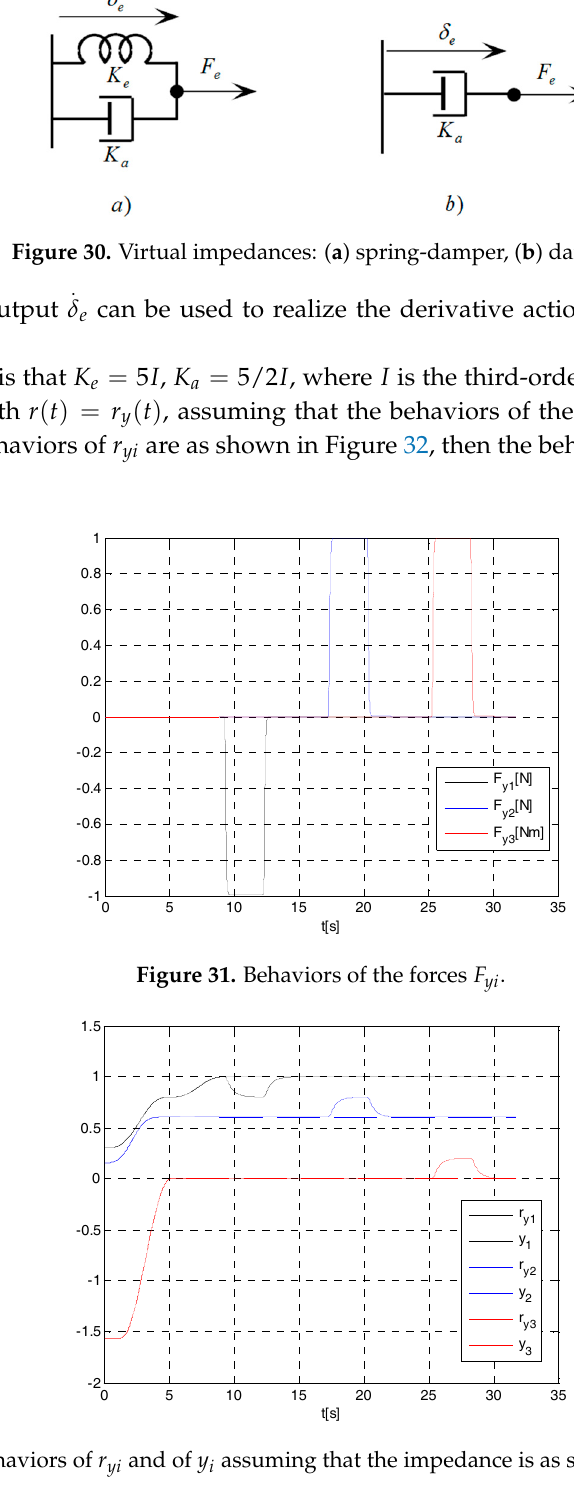
Figure 32. Behaviors of